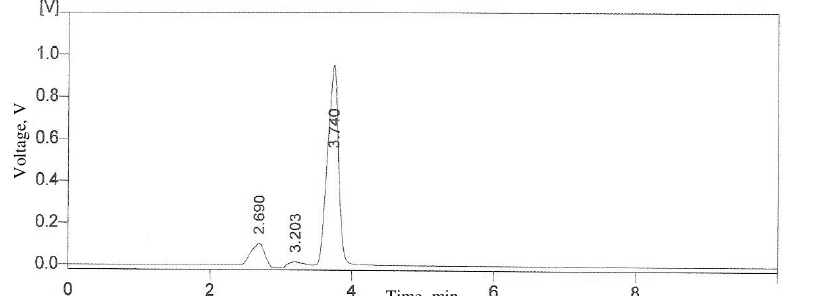
Figure 4. HPLC chromatogram for standard